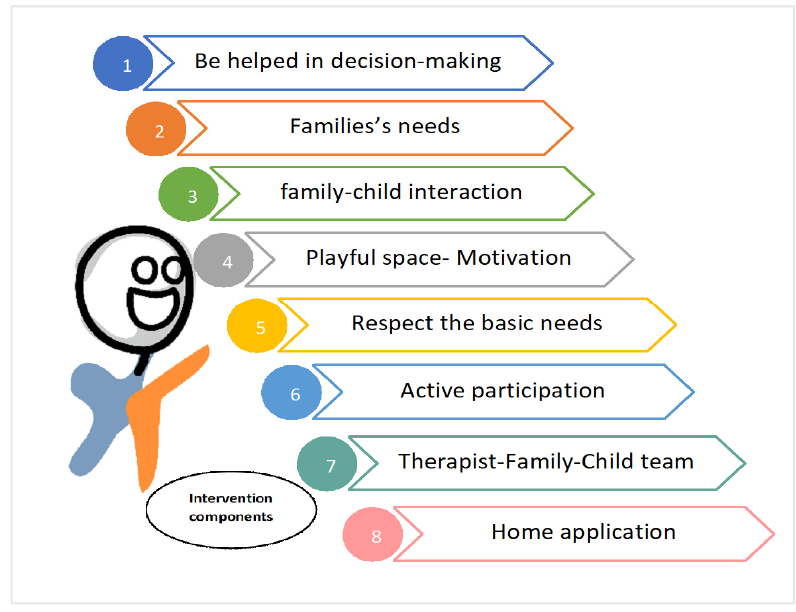
Figure 2. Components that should be included in UCP early intervention.